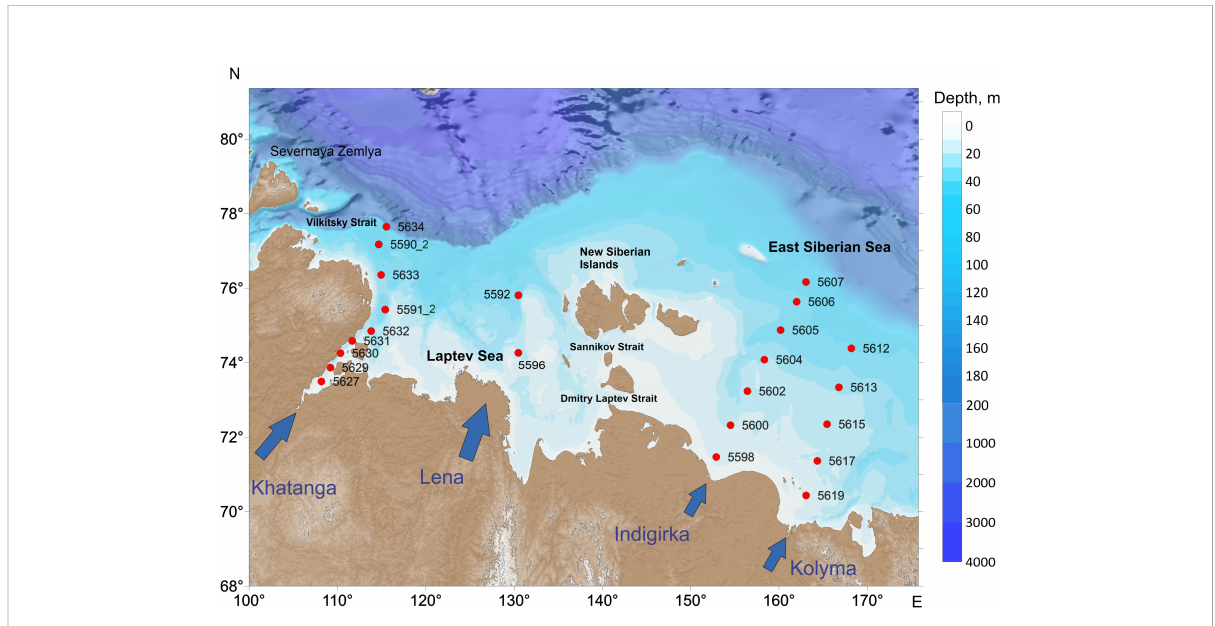
FIGURE 1 Sample site locations during the 69 th cruise of the R/V Akademik Mstislav Keldysh